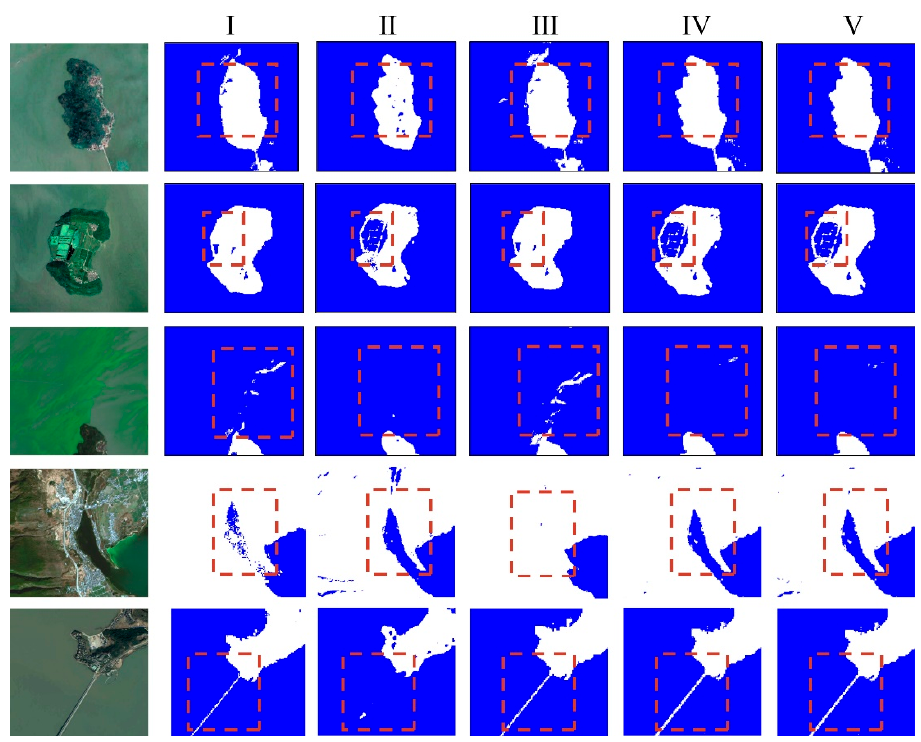
Figure 8. Visual comparisons of the results by different Methods I–V.